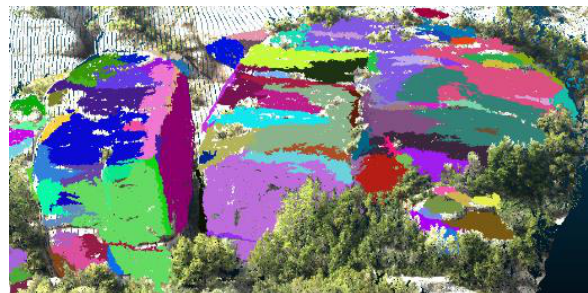
Table 1. Optimized parametrization for the data basis of the study